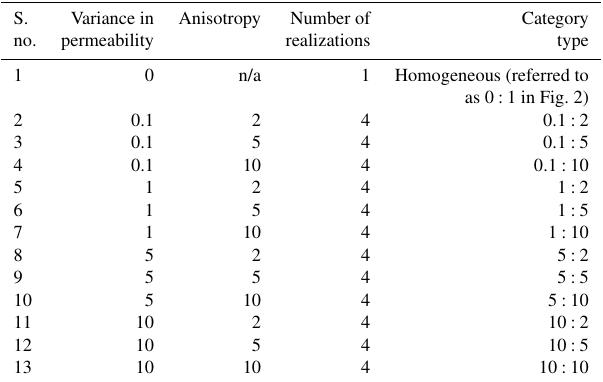
Table 2. Summary of spatially heterogeneous scenarios investigated for each flow regime. S. no. 1 is the homogeneous base case. S. Variance in Anisotropy Number